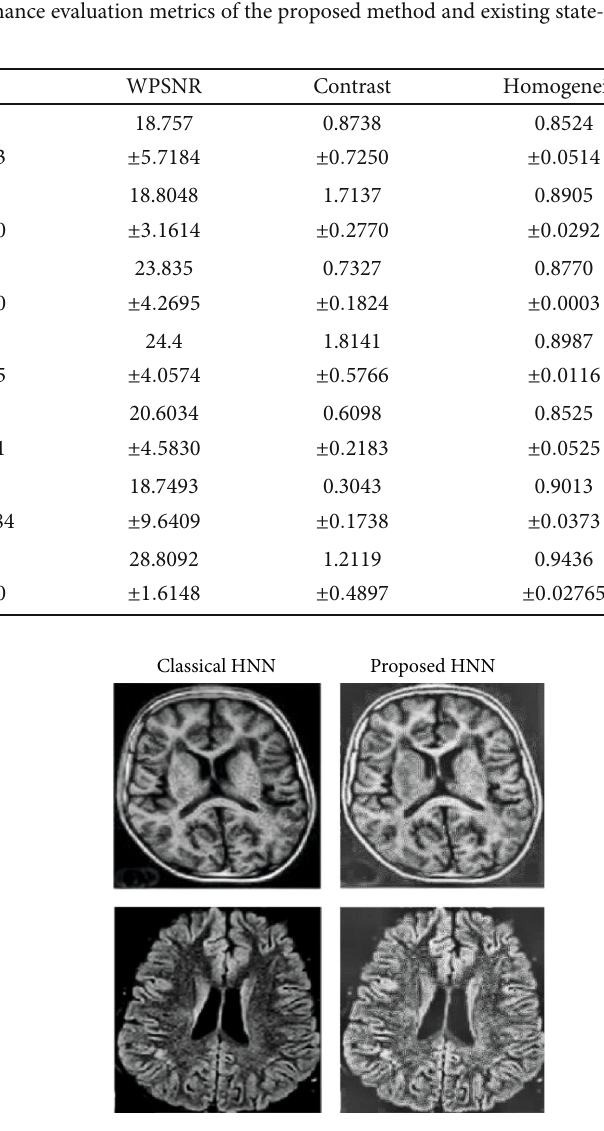
Figure 7: Sample comparing results produced by classical HNN with